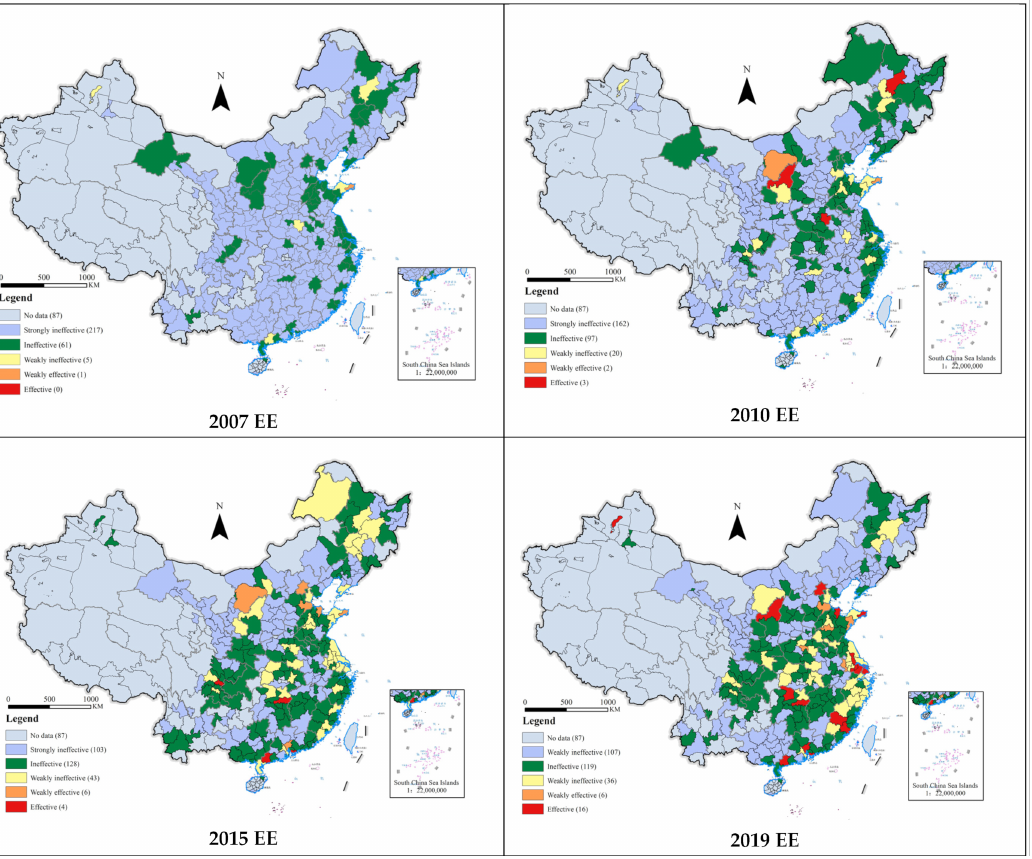
Figure 3. Urban ecological efficiency of Chinese cities in 2007, 2010, 2015, and 2019. Note: this map is based on the standard map with the drawing review number of GS (2020) 4619 on the standard map service website of the Ministry of Natural Resources. There is no modification to the base